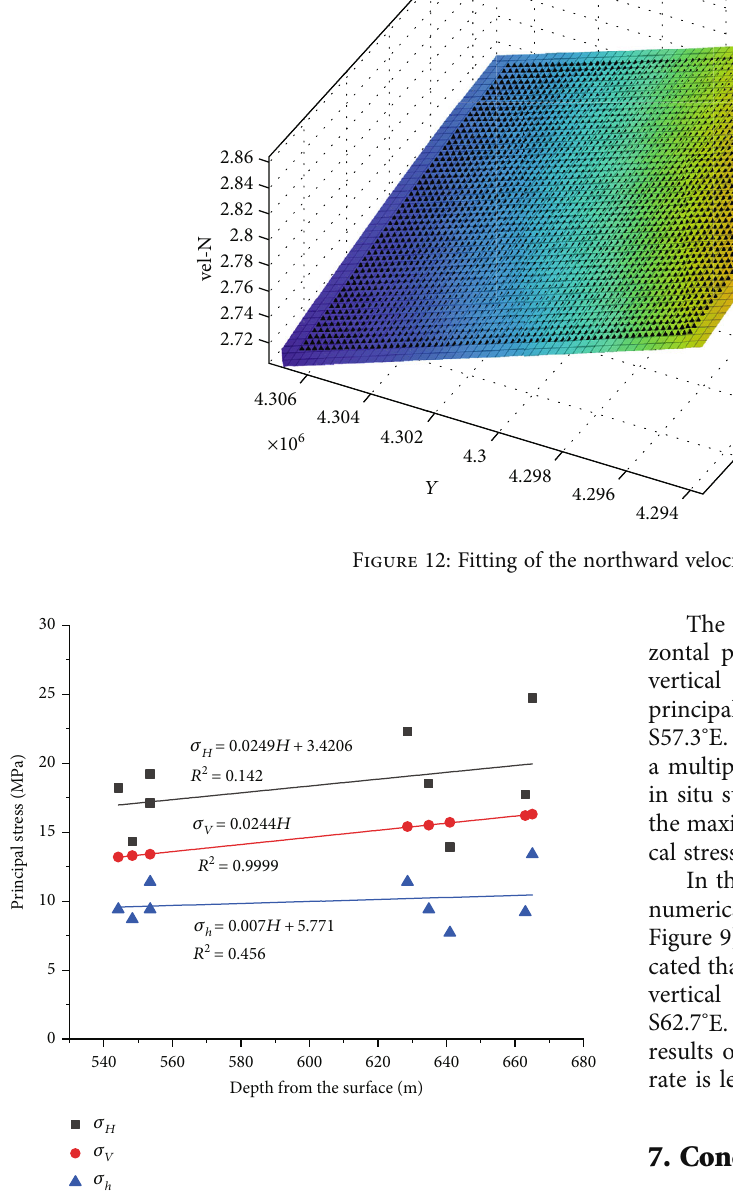
Figure 13: Linear changes in the principal stresses with burial depth along the three